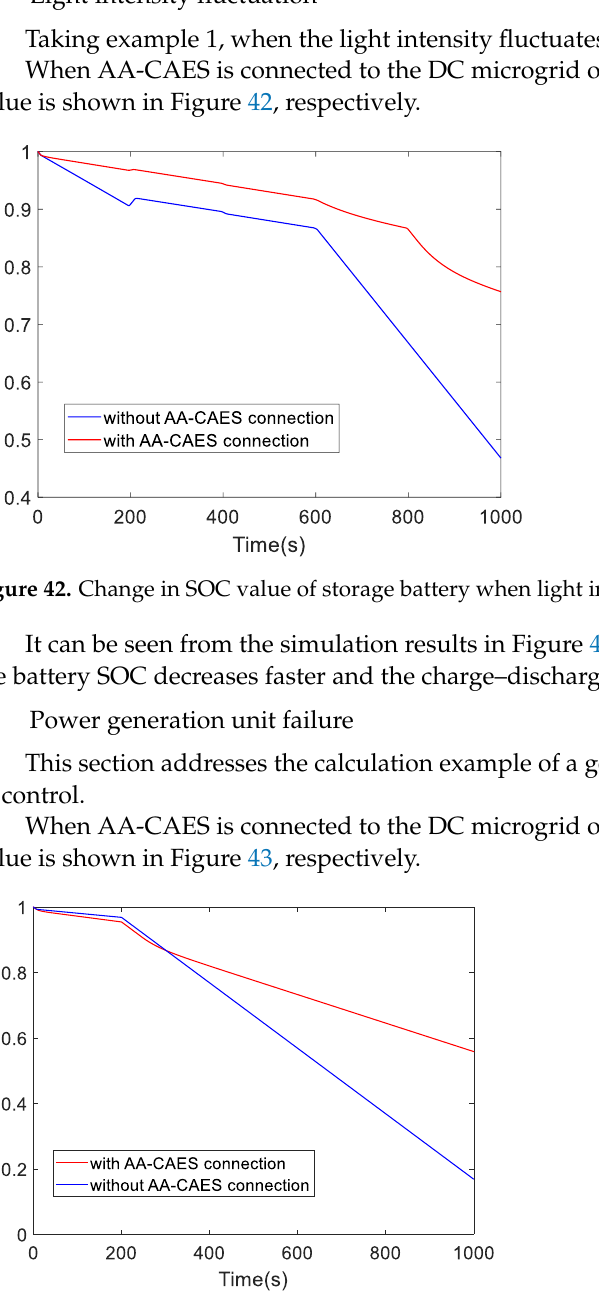
Figure 43. Change in battery SOC value when a generator fails.